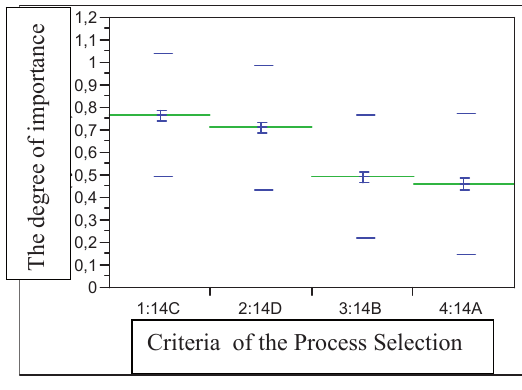
Fig. 1 - Criteria of the Process Selection for BPM activities (in 2006) Source: Tuček and Zámečník, 2007